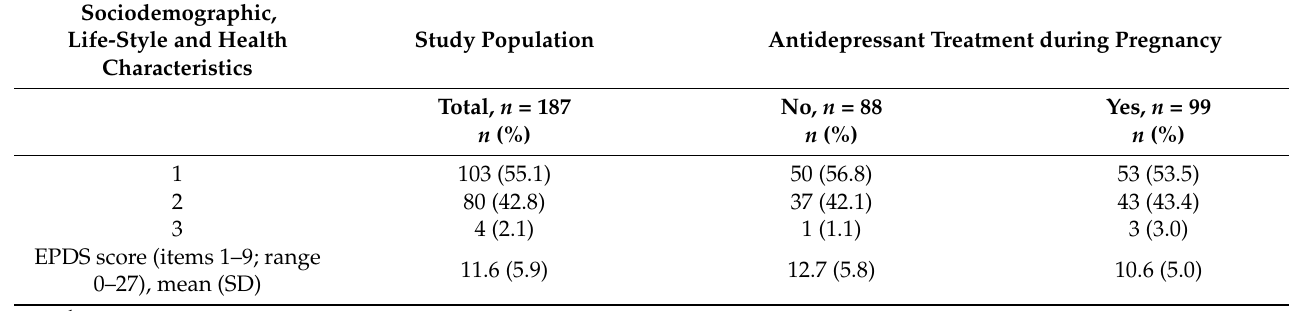
1 The table show crude, non-weighted proportions. Numbers may not add up to total due to missing values (<4%) for 7 women on neuroticism traits ( n = 5), alcohol use ( n = 2), immigrant status ( n = 1) and unplanned pregnancy ( n = 1). Antidepressants included all selective serotonin re-uptake inhibitors (SSRIs, ATC code N06AB), serotonin and norepinephrine reuptake inhibitor (SNRI, ATC codes N06AX, venlafaxine and duloxetine), tricyclics (TCA, ATC code N06AA), and unspecified antidepressant (ATC code N06A-). 2 Western Europe includes France, Italy, Switzerland, and the United Kingdom; Northern Europe includes Finland, Norway and Sweden; Eastern Europe includes Croatia, Poland, Russia, Serbia and Slovenia; North America includes USA and Canada. 3 Women having the first language different from the official main language in the country of residency. 4 Indicates alcohol use after awareness of